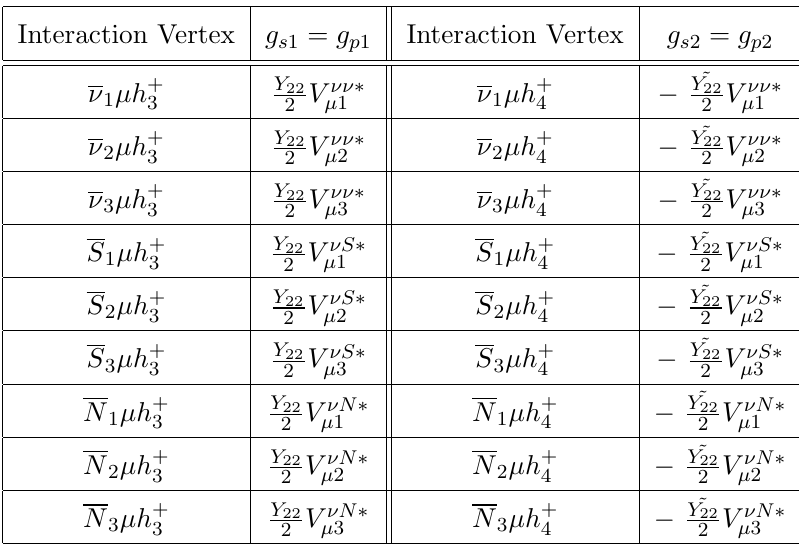
Table 5 . Relevant couplings associated with the Feynman diagrams involving h (cid:0) (cid:12)gure 3.